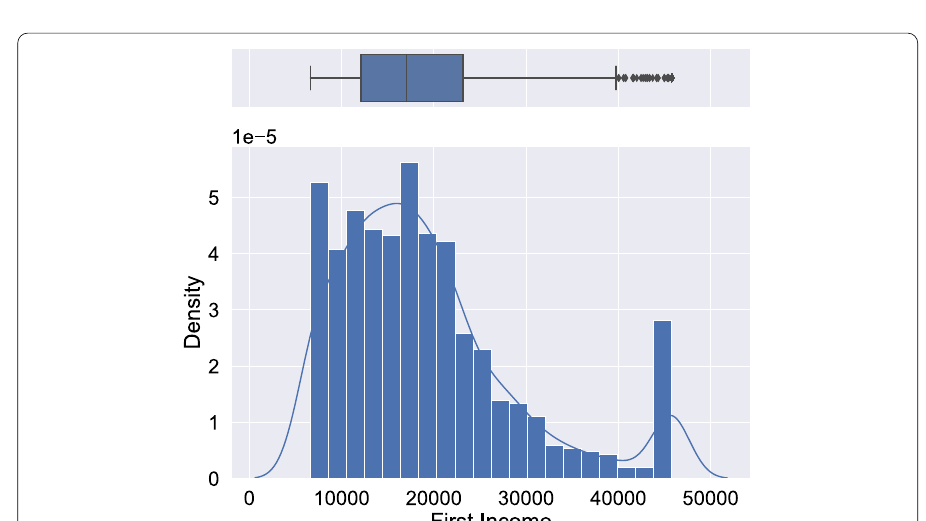
Fig. 3 Density bar plot and boxplot of the winsorized result of the First Income